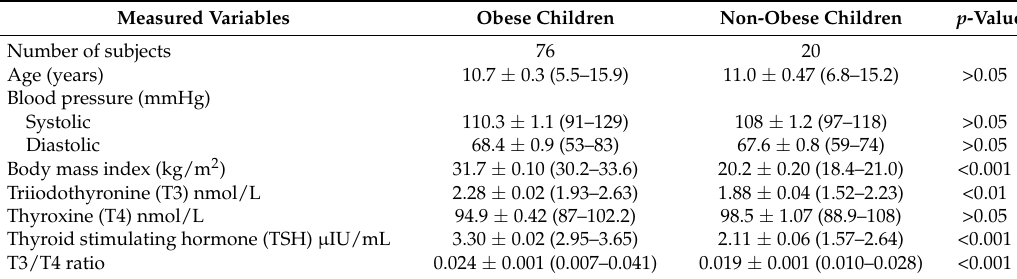
Table 1. Comparison of measured thyroid hormones between obese and non-obese children and adolescents (mean ± standard error of mean). Range is shown between parentheses.